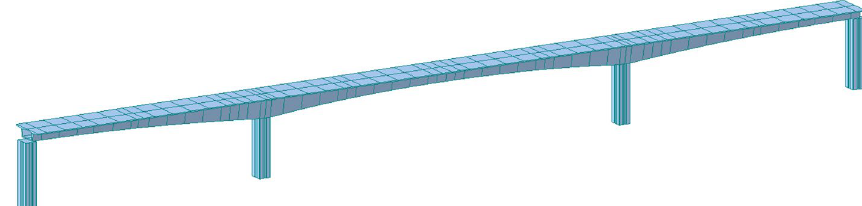
Fig. 20 3D FE model of Talkha Bridge in Midas Civil software